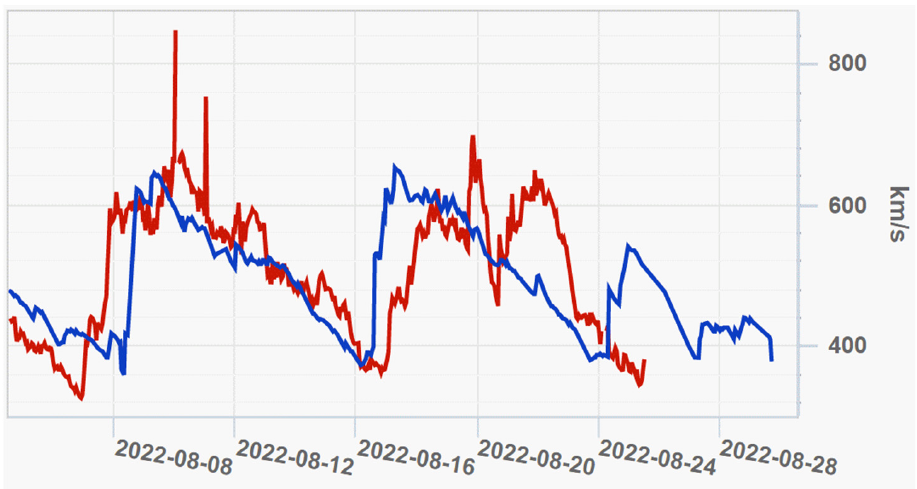
Figure 1. The picture represents measured (blue line) and on-line forecasted by the QSW model (red line) velocities of the SW at the L1 Sun-Earth point from page at the SINP MSU site (https://swx.sinp.msu.ru/weather.php?lang=en (accessed on 25 August 2022)).